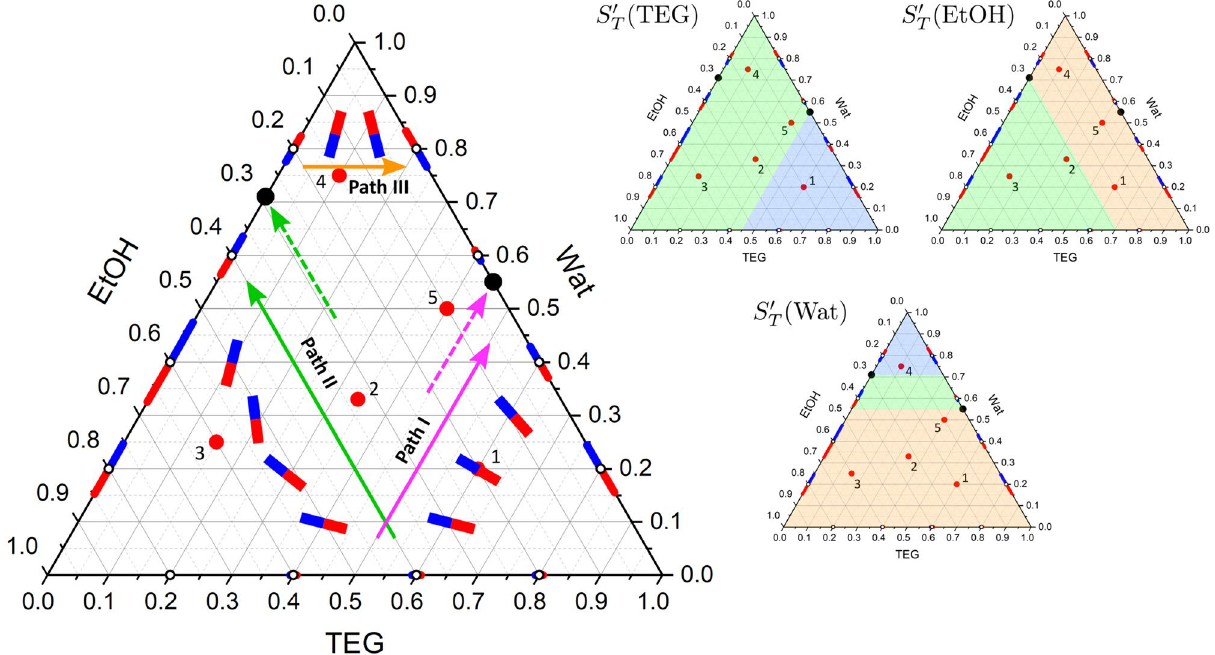
Figure 5. Prediction of the Soret sign in the TEG–Wat–EtOH ternary mixture and consistency check of the experimental results 15,28 . Paths I, II, III trace S ′ T in TEG, EtOH and Water, respectively. The vectors inside a ternary plot without an open circle display the expected orientation and not in scale. The colored triangles illustrate the predicted Soret sign in the mixture: the blue region corresponds to the negative sign, the beige—to the positive sign, and the green region allows a sign change within the